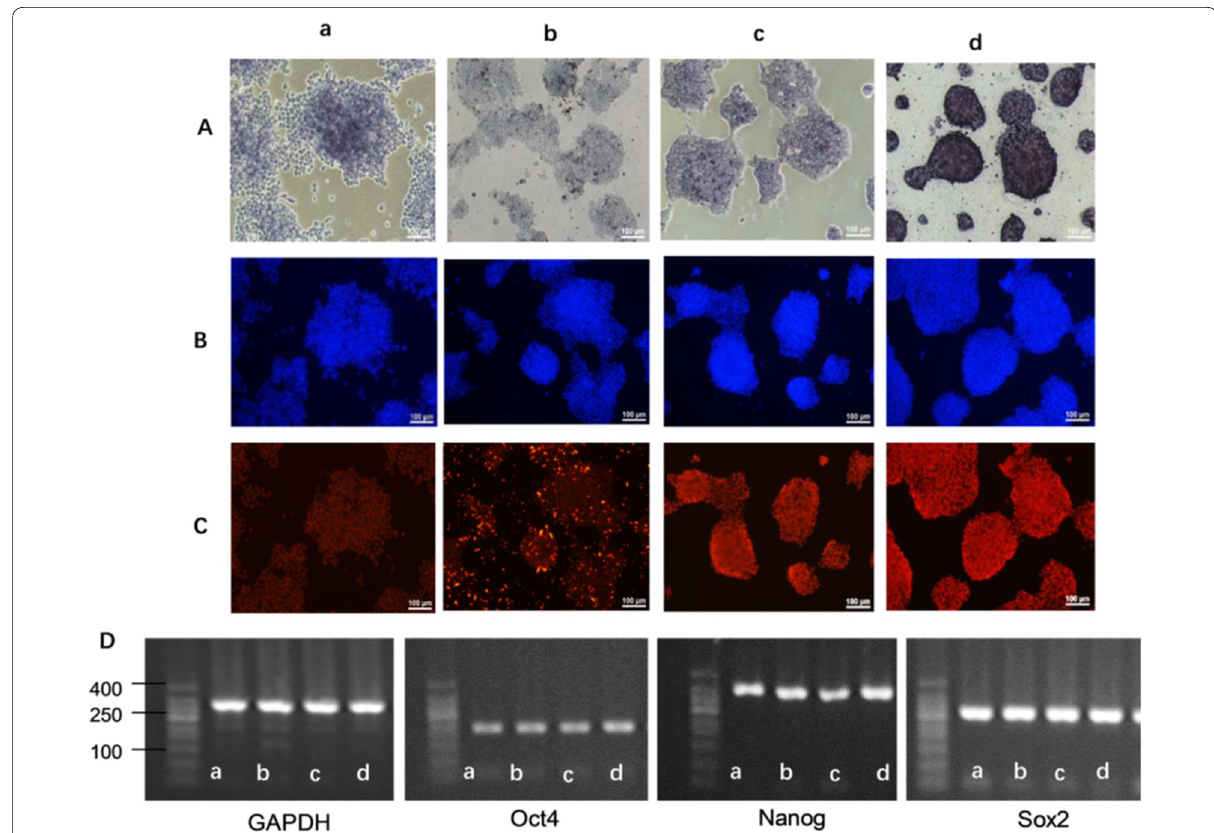
Fig. 6 Cells were cultured with 5 uM SB216763, 1 uM PD0325901, 2 uM SU5402 or their combination. A Alkaline phosphatase staining. Scale bar: 100 μm. B DAPI staining for nuclei. C Immunofluorescence staining for OCT4. Scale bar: 100 μm. D Semi‑quantitative RT‑PCR analysis of Sox2, Oct4 and Nanog mRNA